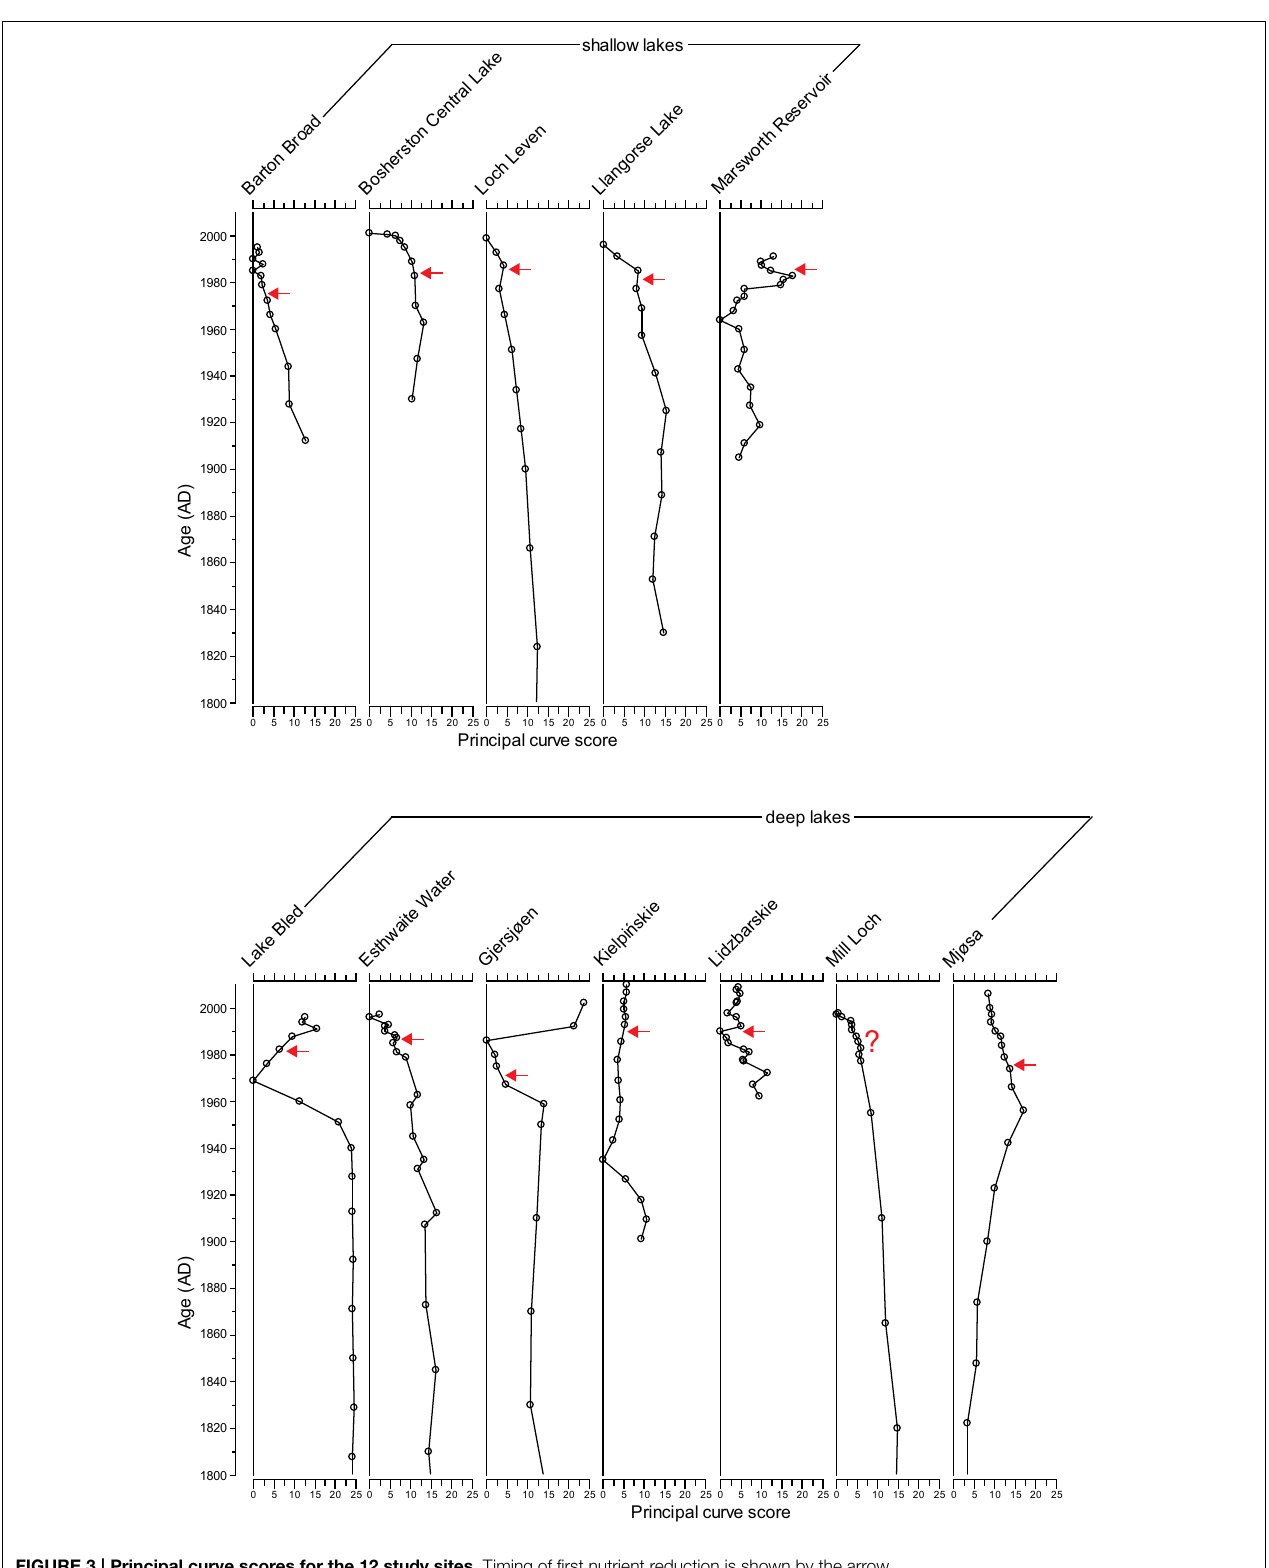
FIGURE 3 | Principal curve scores for the 12 study sites. Timing of first nutrient reduction is shown by the arrow.